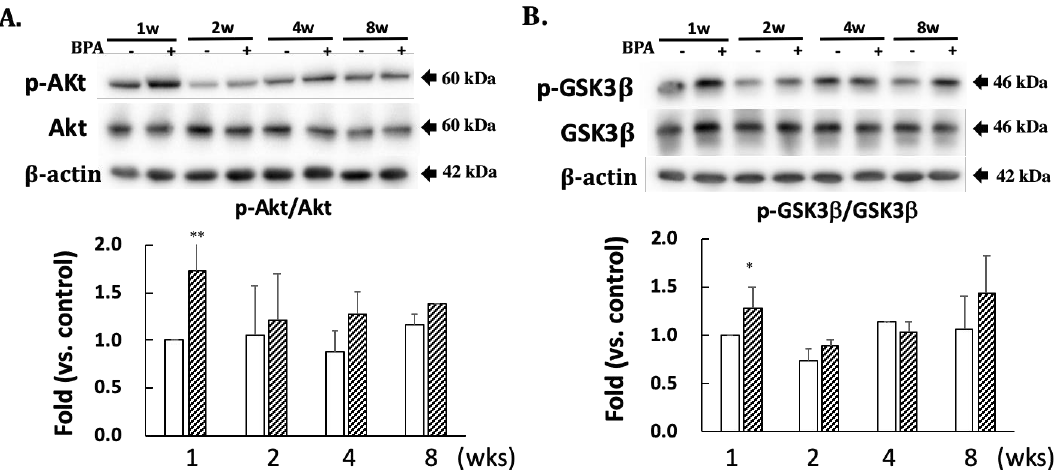
Figure 3. Effect of BPA treatment on phosphorylated Akt/total Akt ( A ); and phosphorylated GSK3β/total GSK3β ( B ). Open column, control and gray column, BPA. Values represent mean ± SD ( n = 3 to 6), * p < 0.05 and ** p < 0.01 vs. control group.